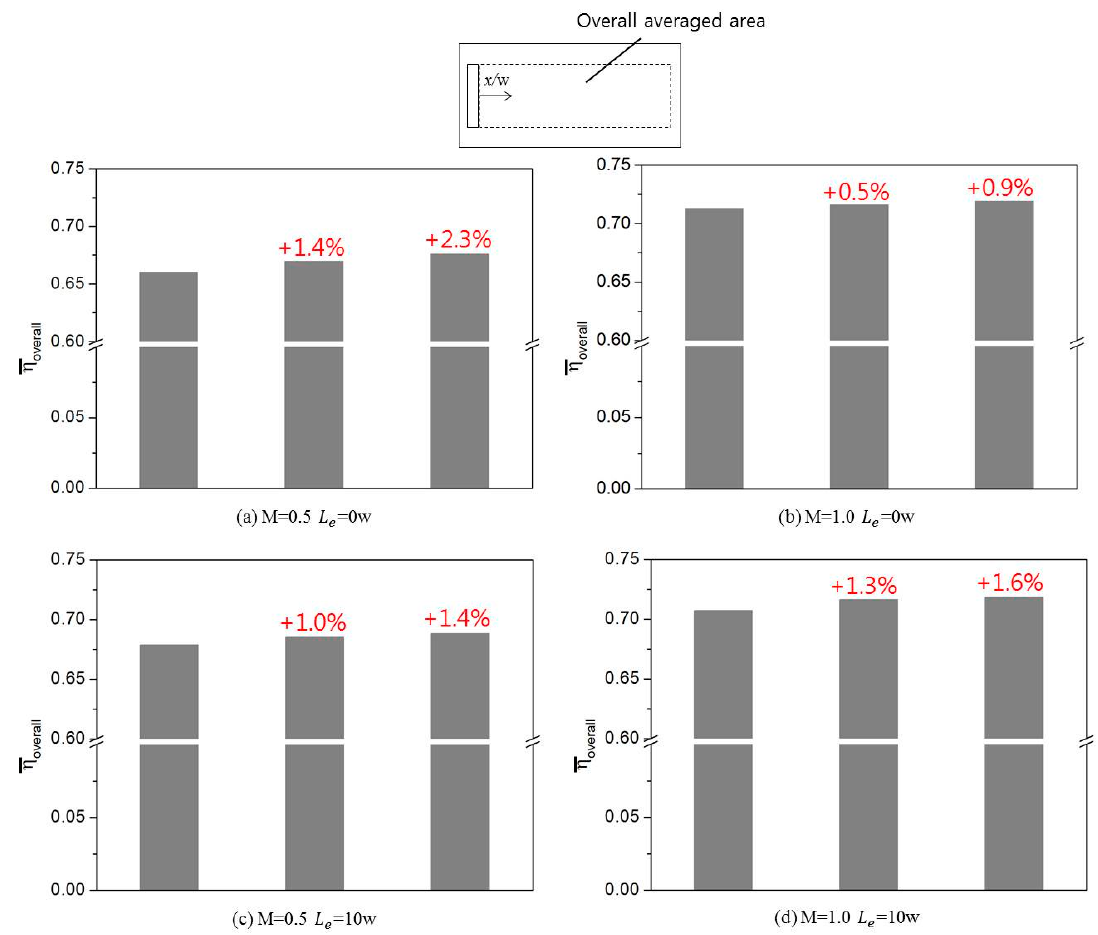
Figure 10. Overall area averaged film cooling effectiveness.